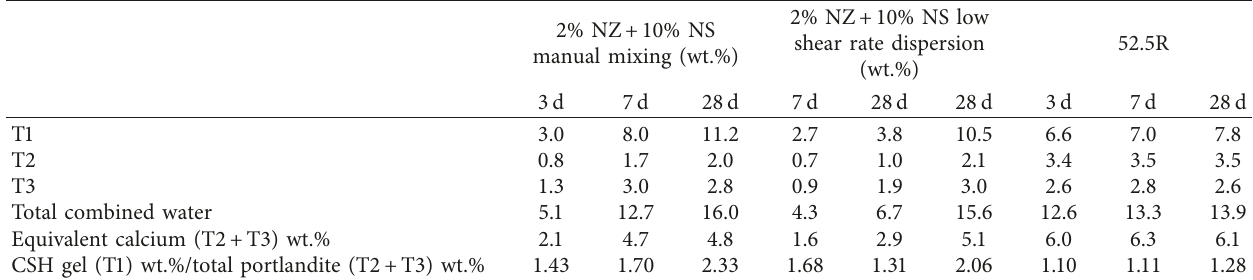
Total combined water (T1+T2 +T3) wt.% Equivalent calcium (T2 +T3) wt.% Table 3: Water losses associated with different phases in cement pastes with 2 wt.% of nanozinc (NZ) +10 wt.% nanosilica